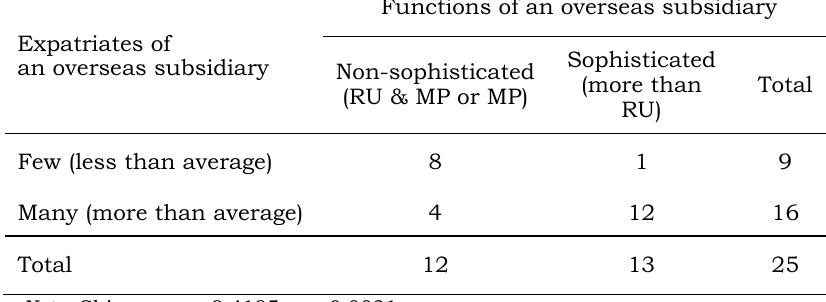
Functions of an overseas subsidiary Sophisticated Non-sophisticated Total (more than (RU & MP or MP) RU)